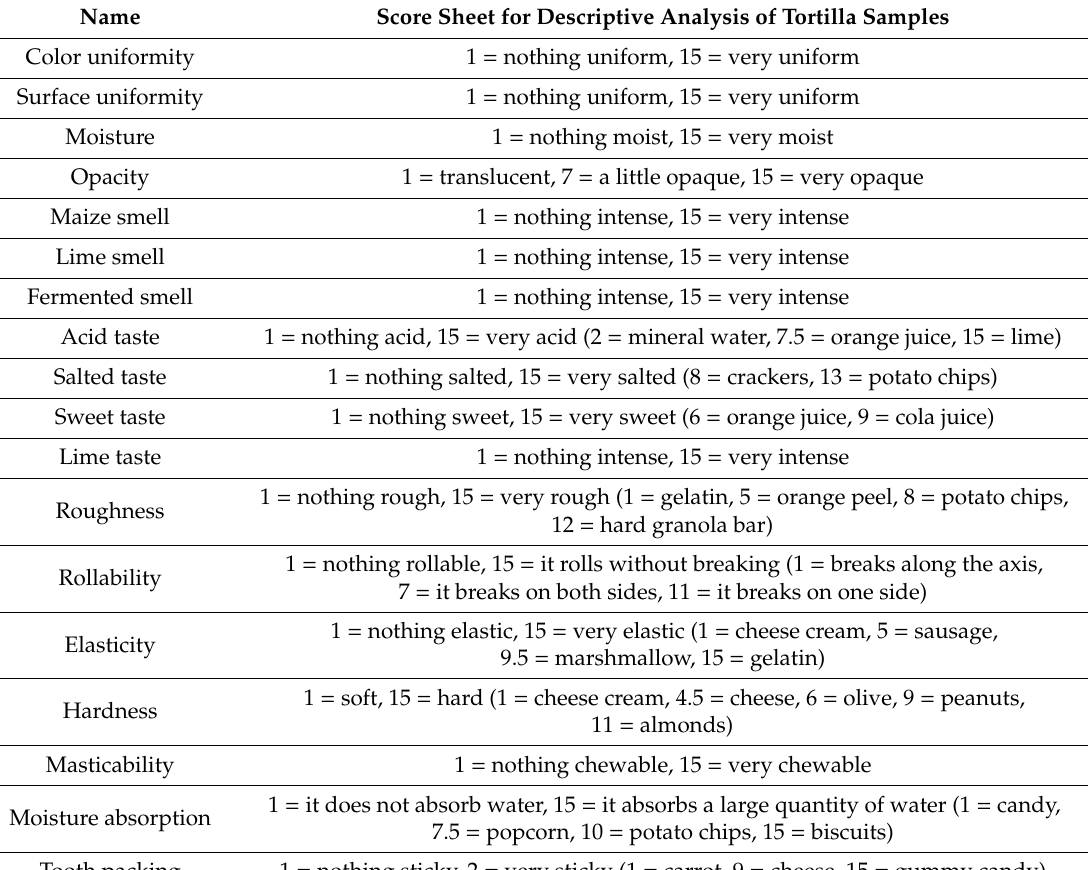
Table 2. Sensory analysis and subjective textural characteristics scores